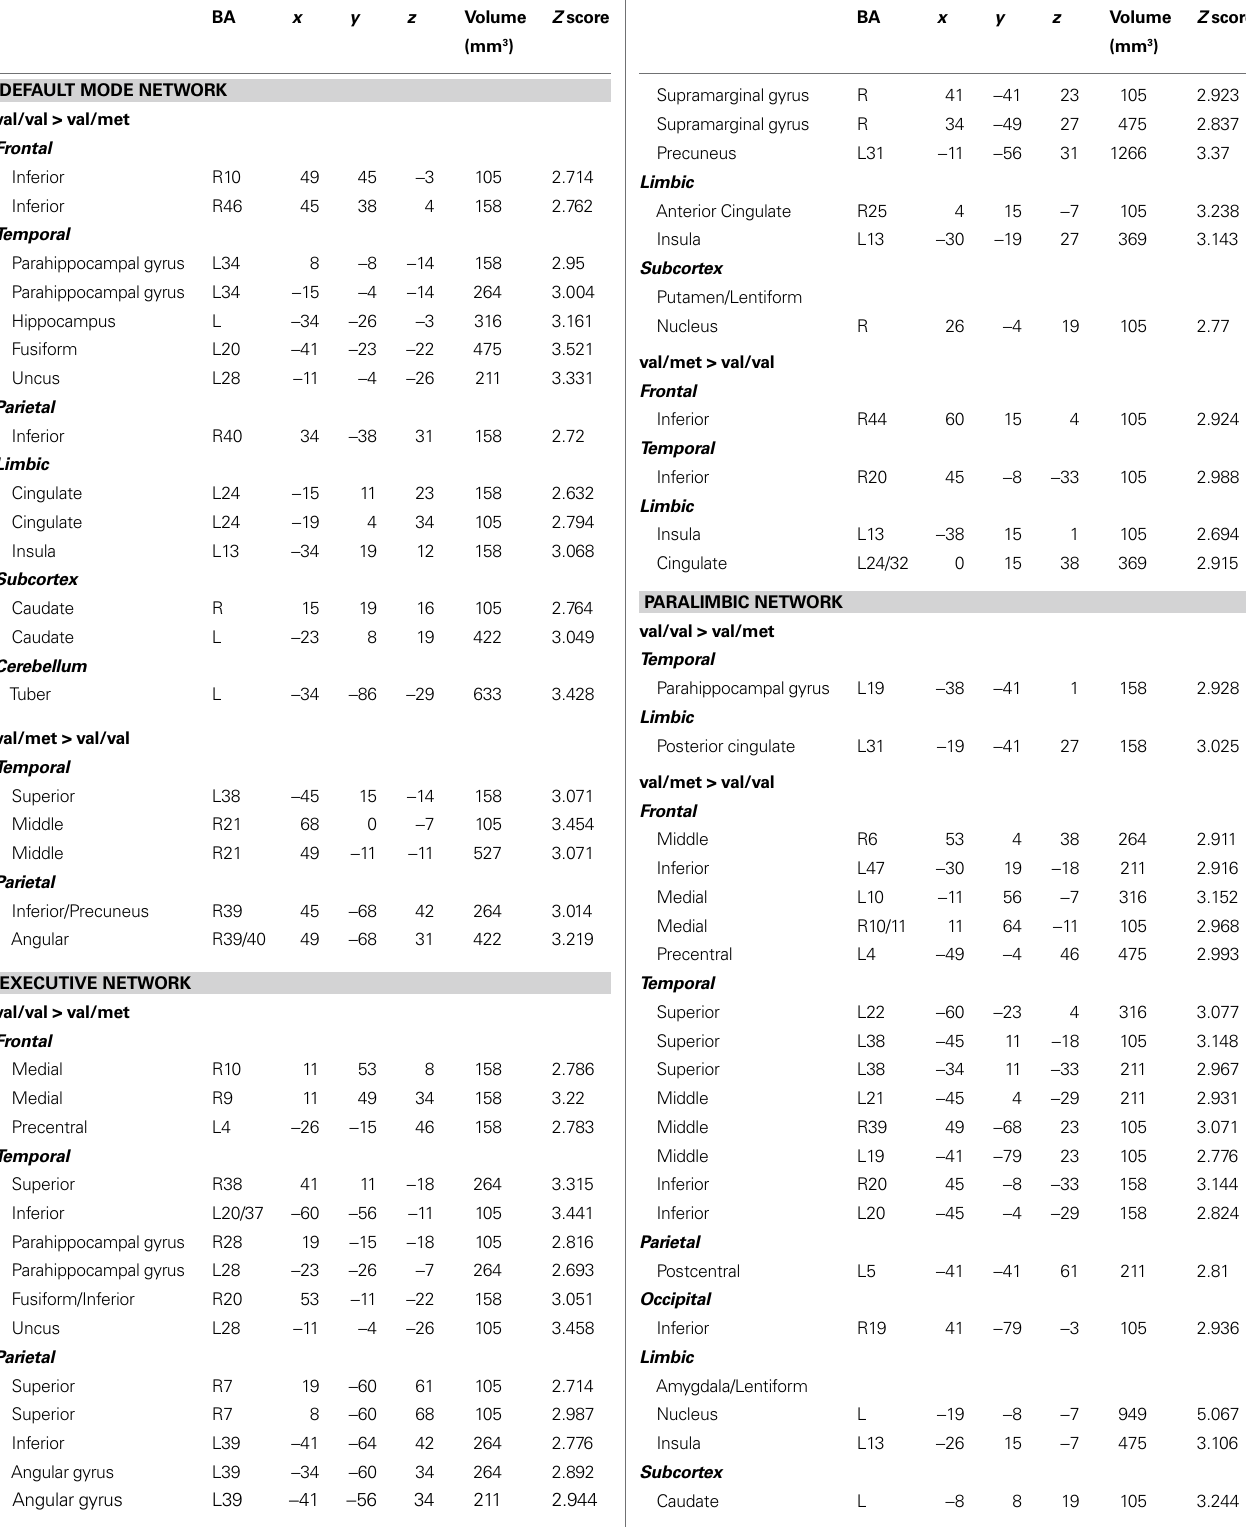
Table 2 | Regions of signifi cant ( p < 0.01, uncorrected) BDNF gene-group differences functional connectivity in across three resting-state networks. BA x